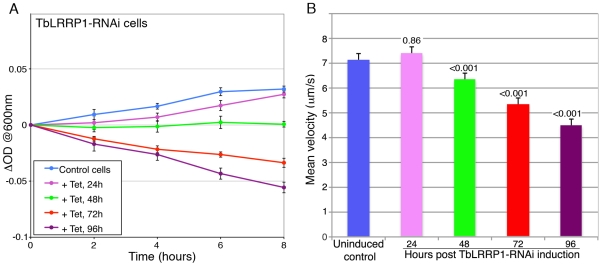
TbLRRP1-RNAi leads to defects in cell motility.At different time points post-RNAi induction, cells were diluted using fresh medium to desired concentrations for sedimentation assays (A) and individual cell tracking analyses (B). Results are shown as mean±SD, n = 3 (A) or mean velocity±SEM, 20–25 cells were measured in each of 3 independent experiments (B). P values are indicated on top of each measurement for the TbLRRP1-RNAi cells shown in (B). Sample movies used for the tracking analyses are shown in Movies S1, S2, S3, S4, S5.